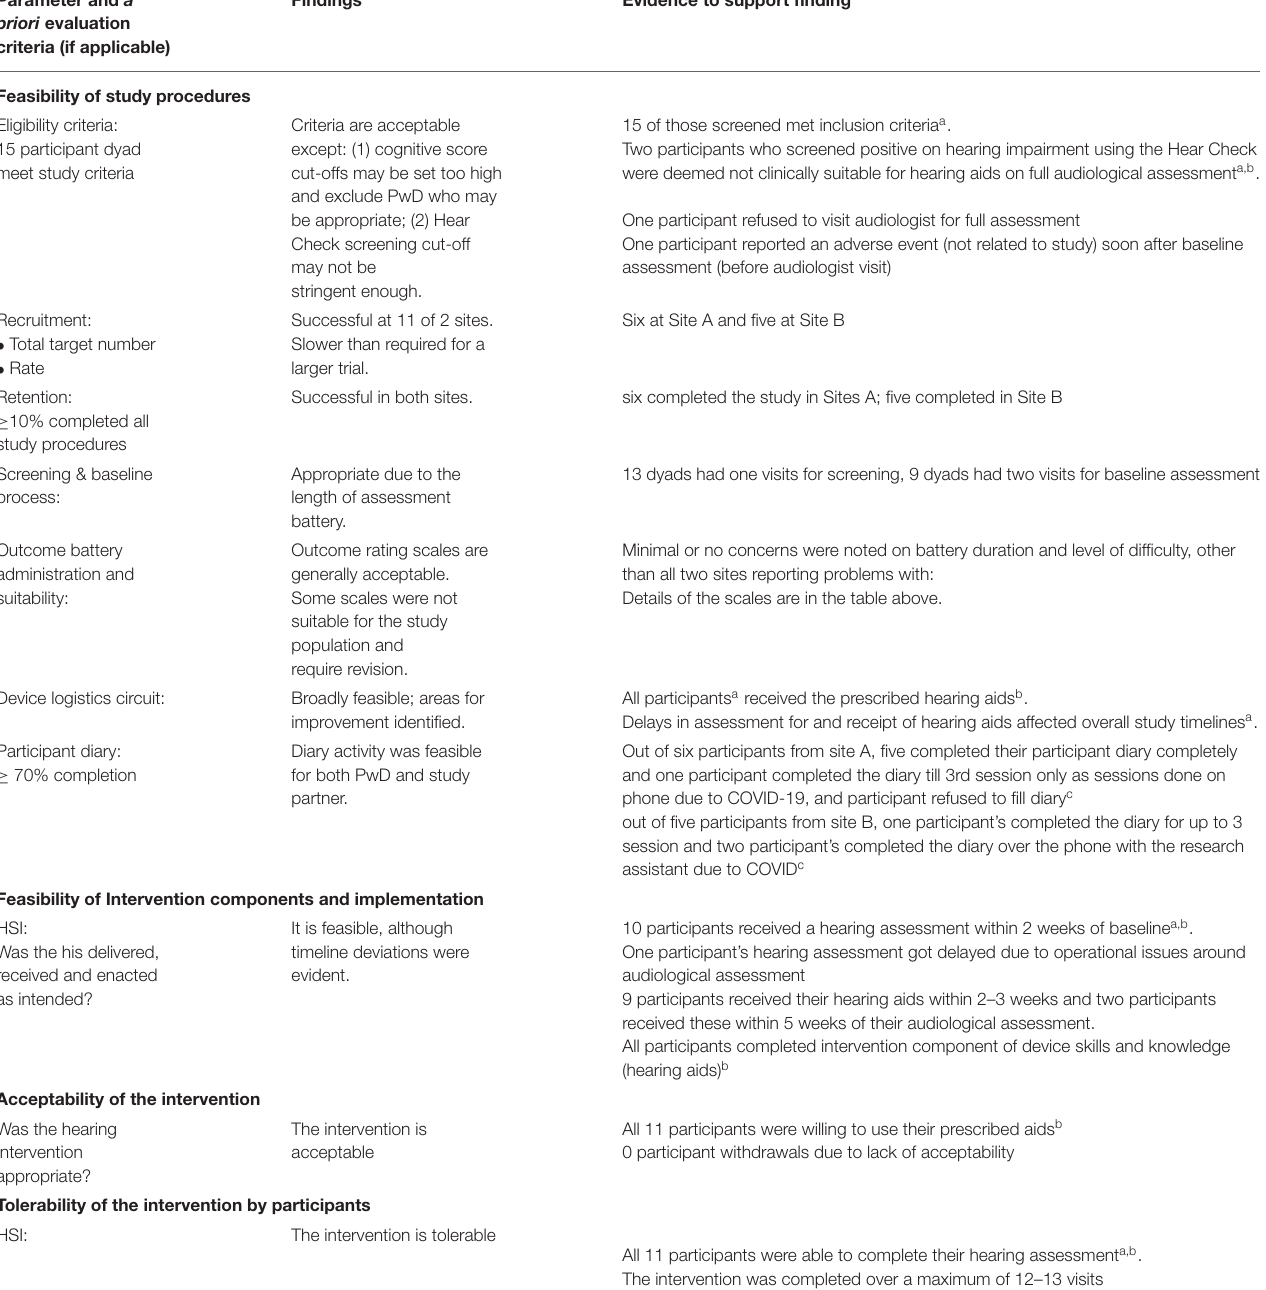
Findings Evidence to support finding